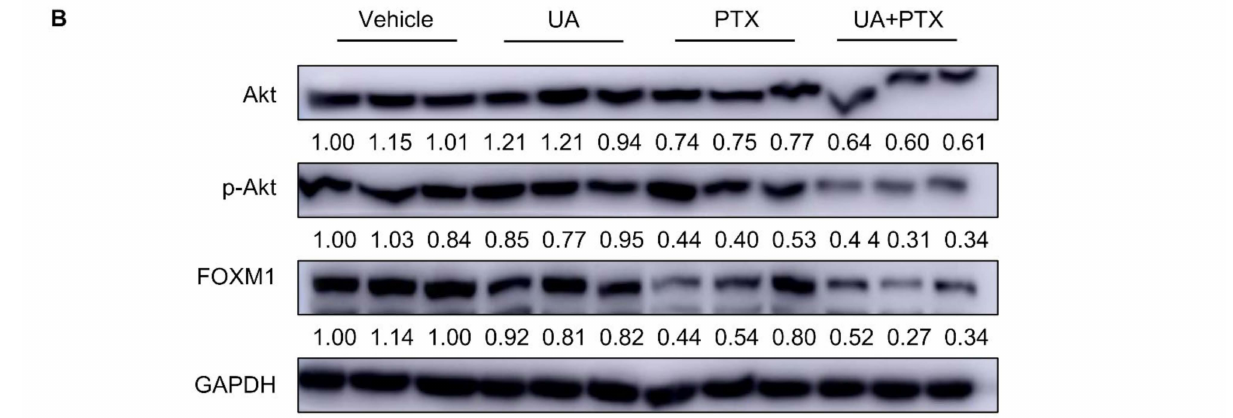
Figure 9. Histological examination of tumor tissue ( A ). Tumor tissues were examined using hematoxylin and eosin staining (upper row) and Ki-67 immunohistochemistry staining (lower row). Scale bar: 100 µ m. ( B ). Expression of Akt/p- Akt/FOXM1 in tumor tissue was examined by western blotting. GAPDH is the internal control. Quantification of bands was calculated using Image J. Vehicle, DPBS; UA, ursolic acid 30 µ M; PTX, paclitaxel 25 nM; UA + PTX, combination treatment of ursolic acid 30 µ M and paclitaxel 25